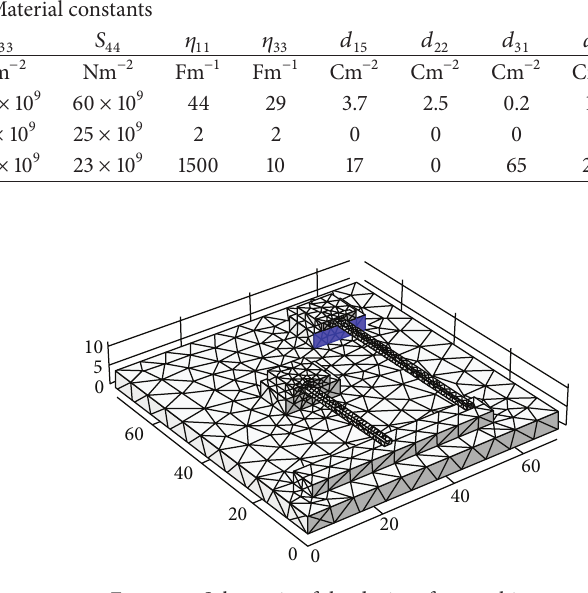
Figure 5: Schematic of the device after meshing.